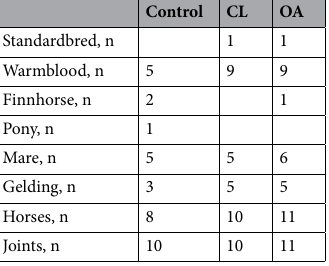
Table 1. Breeds and gender of the sampled horses. CL = contralateral, OA = osteoarthritis.